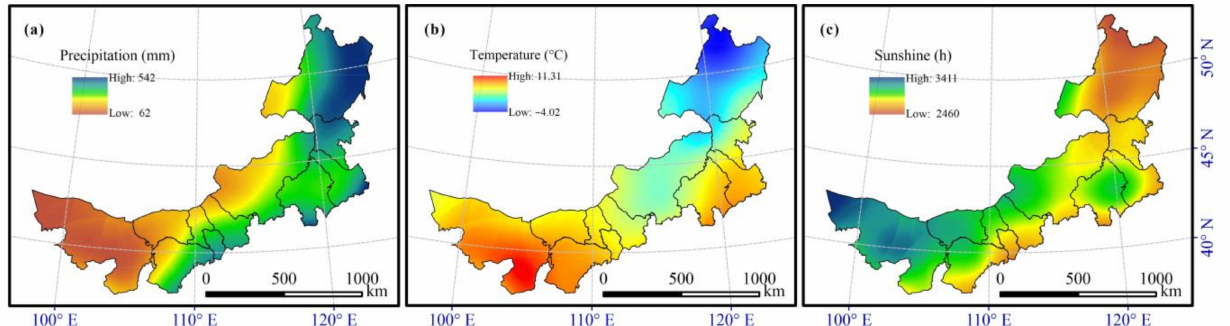
Figure 11. Map of ( a ) the total annual precipitation, ( b ) average annual temperature, ( c ) total annual sunshine hours in Inner Mongolia from 2000 to